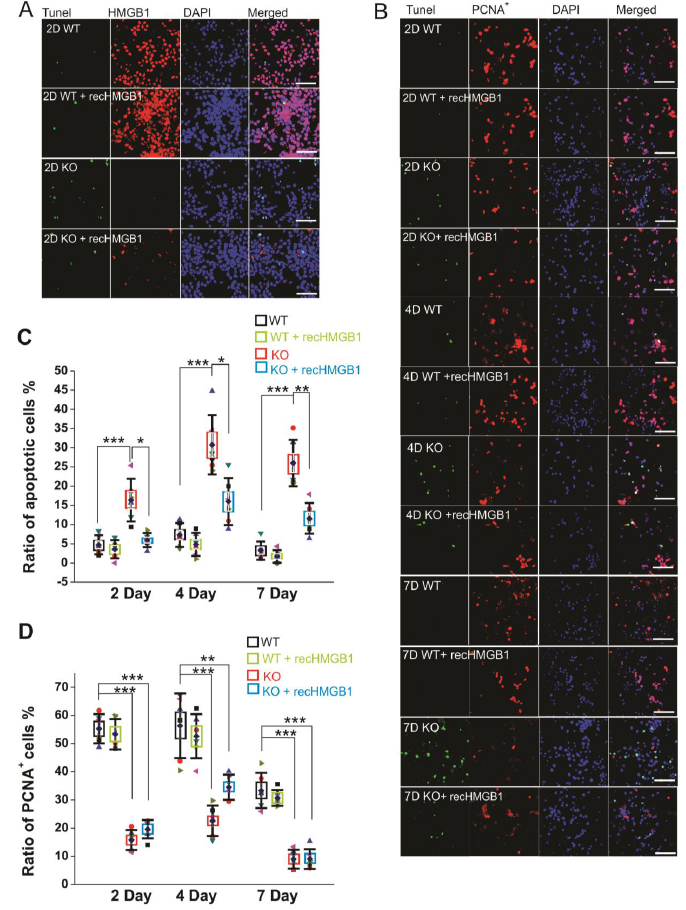
Figure 3. Apoptotic and proliferating activity of in vitro cultured E16 cortical neuronal cells. ( A ) Tunel staining of E16 cortical neuronal cells cultured for 2 days. All of the samples have been co-stained with anti-HMGB1 antibody (Alexa 568) and DAPI. Scale bar indicates 40 µ m. ( B ) Tunel staining and anti-PCNA antibody (Alexa 568) staining of E16 cortical neuronal cells cultured for two, four, and seven days. Cell nuclei have been stained with DAPI. Recombinant HMGB1 protein (recHMGB1) was coated on the matrix and added into the culture medium at 10 µ g / mL. Scale bar indicates 50 µ m. ( A ) and ( B ) are the confocal z-stack max projections of 10 µ m. ( C ) The statistics of apoptotic cells in each group of cultured cells shown in ( B ). ( D ) The statistics of proliferating cells in each group of cultured cells shown in ( B ). For the statistics in ( C ) and ( D ), the cortical neurons from six KO and six WT E16 brains were collected and cultured for the immunostaining and analysis. For each brain sample, three repeats were applied. Mean values ± S.D. (error bars) and S.E.M (Boxes) are indicated ( n = 6; *** p < 0.001; ** p < 0.01; * p < 0.05; unpaired t -test,